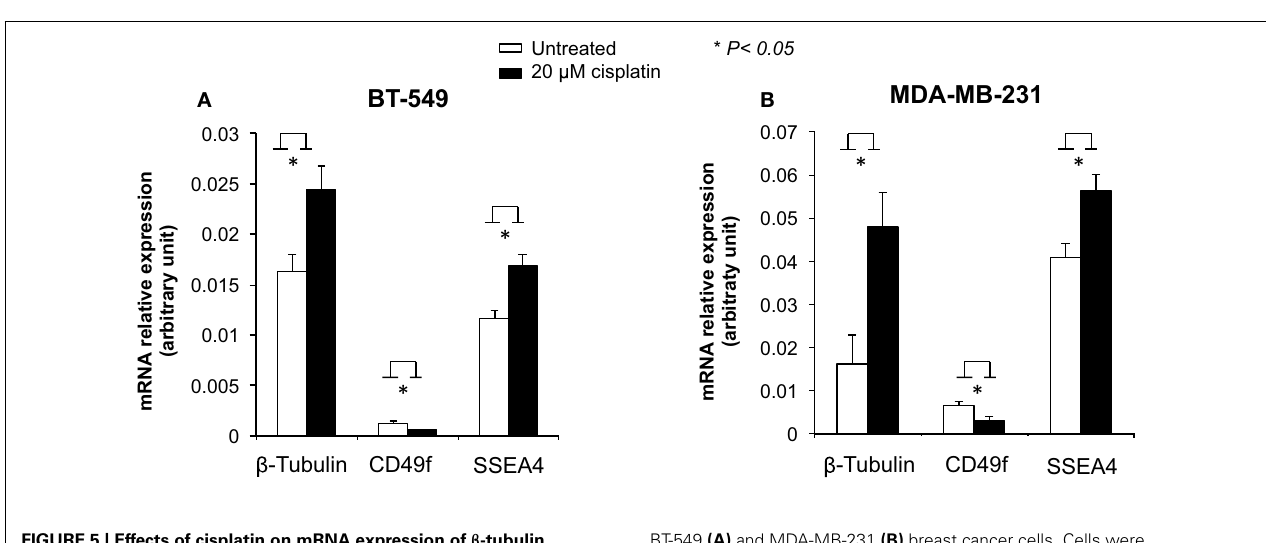
FIGURE 5 | Effects of cisplatin on mRNA expression of β -tubulin, CD49f, and SSEA4 in breast cancer cells . Individual PCR reactions were normalized against internal positive control ( β -actin) and plotted as the mRNA relative expression for both untreated and cisplatin-treated